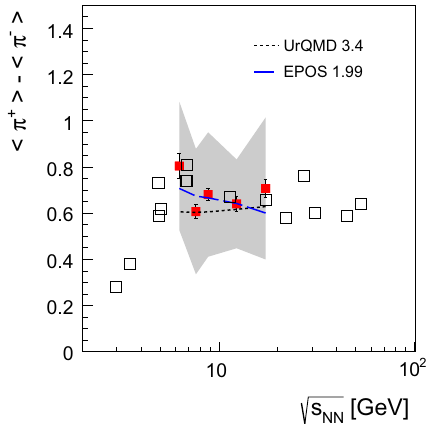
(cid:22) (cid:21) (cid:22) (cid:21) − π − π + Fig. 45 Difference in inelastic p + p interactions as function of collision energy. Solid red squares depict NA61/SHINE resultsfromthisanalysis,opensquaresshowpreviouslypublishedmea- surements [11,37,38,44]. Statistical uncertainties of the NA61/SHINE results are indicated by bars, systematic uncertainties by the shaded band.The EPOS [21]and U r QMD [27,28]modelpredictionsareshown as dashed and dotted lines,